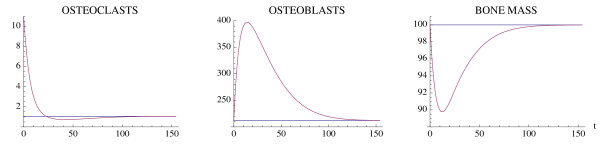
A single event of normal bone remodeling initiated by a momentary perturbation of the osteoclast nontrivial steady state population by an increase of 10 cell units. System of equations (1): The osteoclast population first decreases with a consequent increase in osteoblast population and a resorption of bone mass, followed by a return to steady-state levels. The blue line represents the steady-state solution. The parameters are α1 = 3.0, α2 = 4.0, β1 = 0.2, β2 = .02, g11 = .5, g22 = 0.0, g12 = 1.0, and g21 = -0.5. The nontrivial steady state with these parameters is  = 1.06 and  = 212.13. The initial conditions are C(0) = 11.06 and B(0) = 212.13. The bone mass parameters are k1 = .24, k2 = .0017, as in [22].